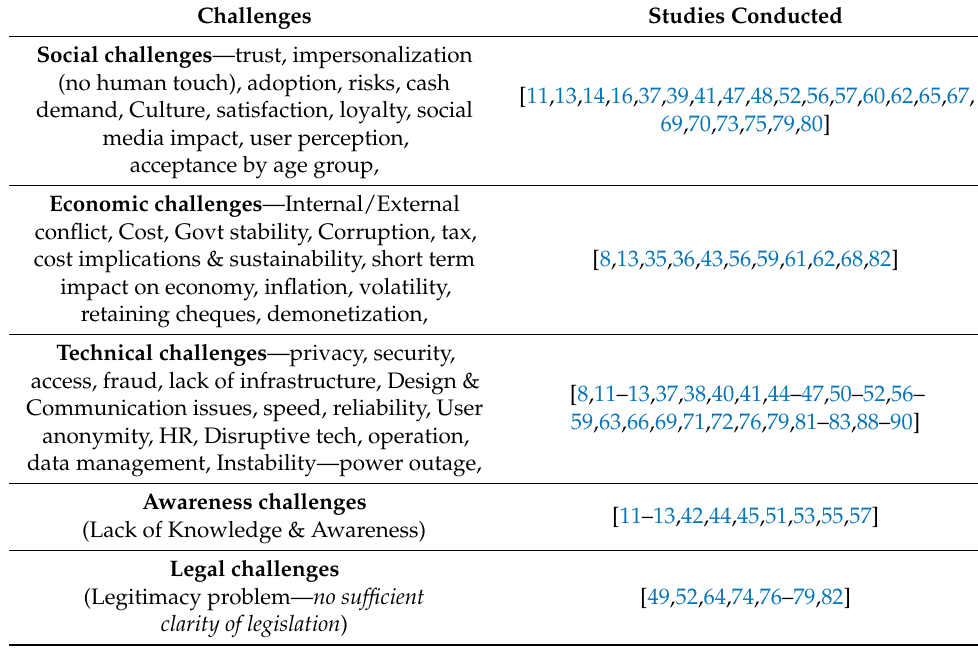
Figure 4. Classification of digital payment technology challenges. Table 6. Challenges of digital payment technologies and reviewed studies.